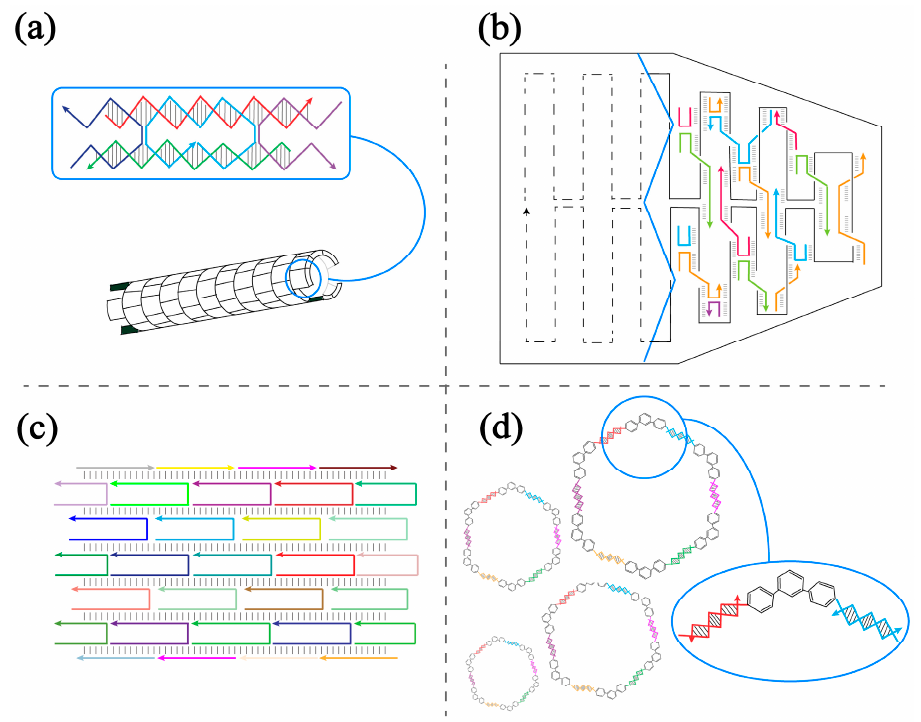
Figure 1. Scheme of self-assembly methods. The solid line with an arrow represents a single strand of DNA. ( a ) Tile-based self-assembly method. ( b ) DNA origami-based self-assembly method. ( c ) DNA brick-based self-assembly method. ( d ) Supramolecular DNA assembly method.